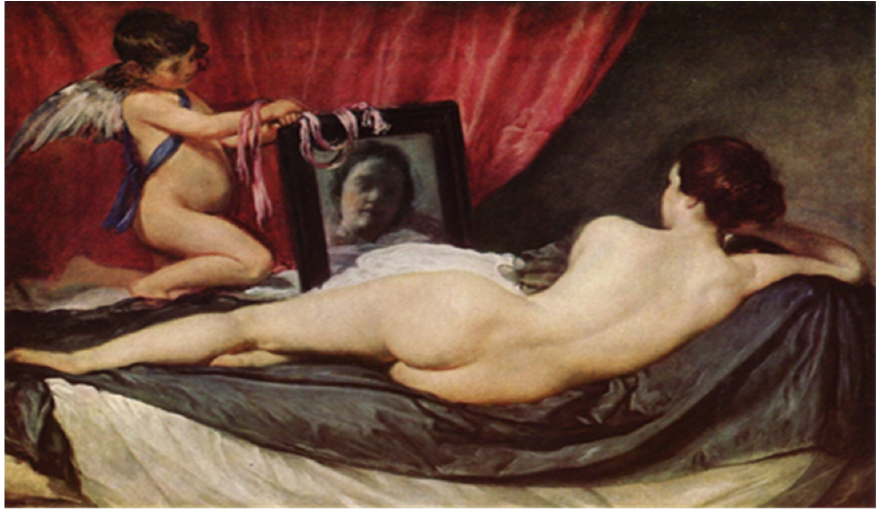
Figure 4. Diego Velázquez. “The Rokeby Venus” (circa 1648–1651). Among prominent Russian artists of the 20th century, Aleksandr Deineka has two notable paintings in this